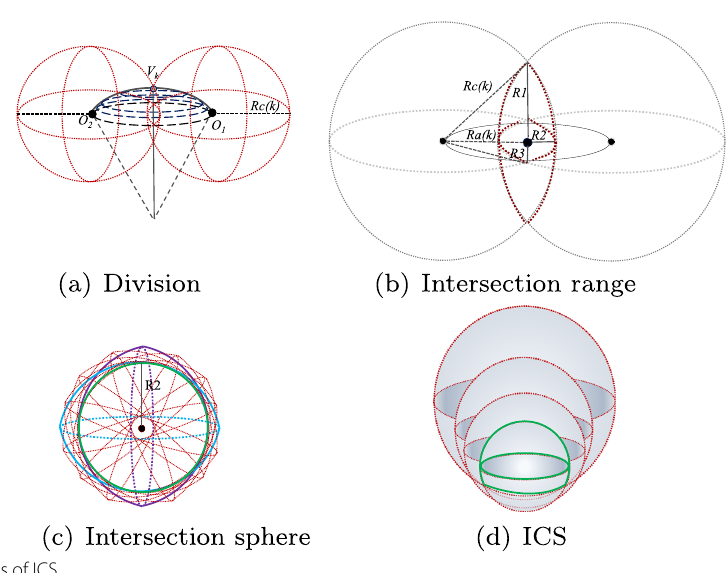
, Rc ( k )) Hence, for ∀ V k ∈ V , the ICS ( V k can be calcu- lated using the communication range and the deviation radius. The ICS of node satisfies the following conditions: